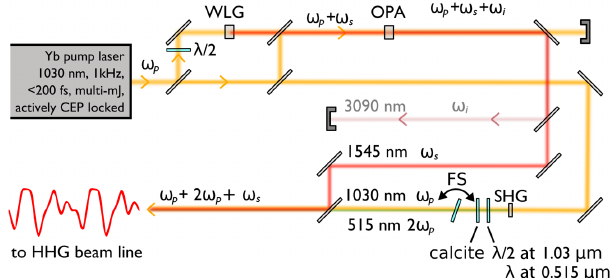
FIG. 2. Layout of the waveform synthesizer. A CEP-stabilized, multi-mJ, diode-pumped femtosecond Yb-based pump laser and a collinear white-light-seeded three-stage OPA are followed by a multicolor interferometer with subcycle stability and a second- harmonic generation (SHG) crystal in the 1 - μ m arm (see Ref. [24] for more details). White-light generation (WLG); fused silica